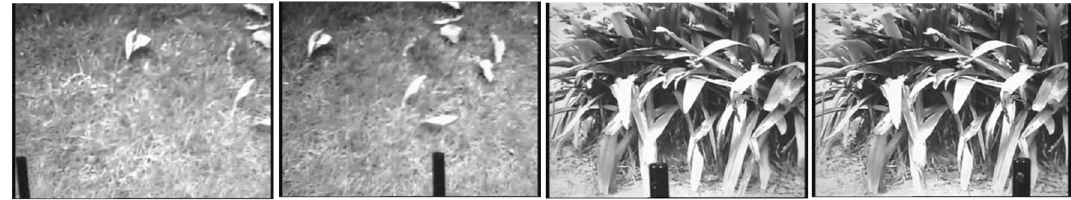
Figure 18. Four sample frames in the segments of mobile in-vehicle videos. Table 1. PSNR values and the correlation coefficients for five segments of video.